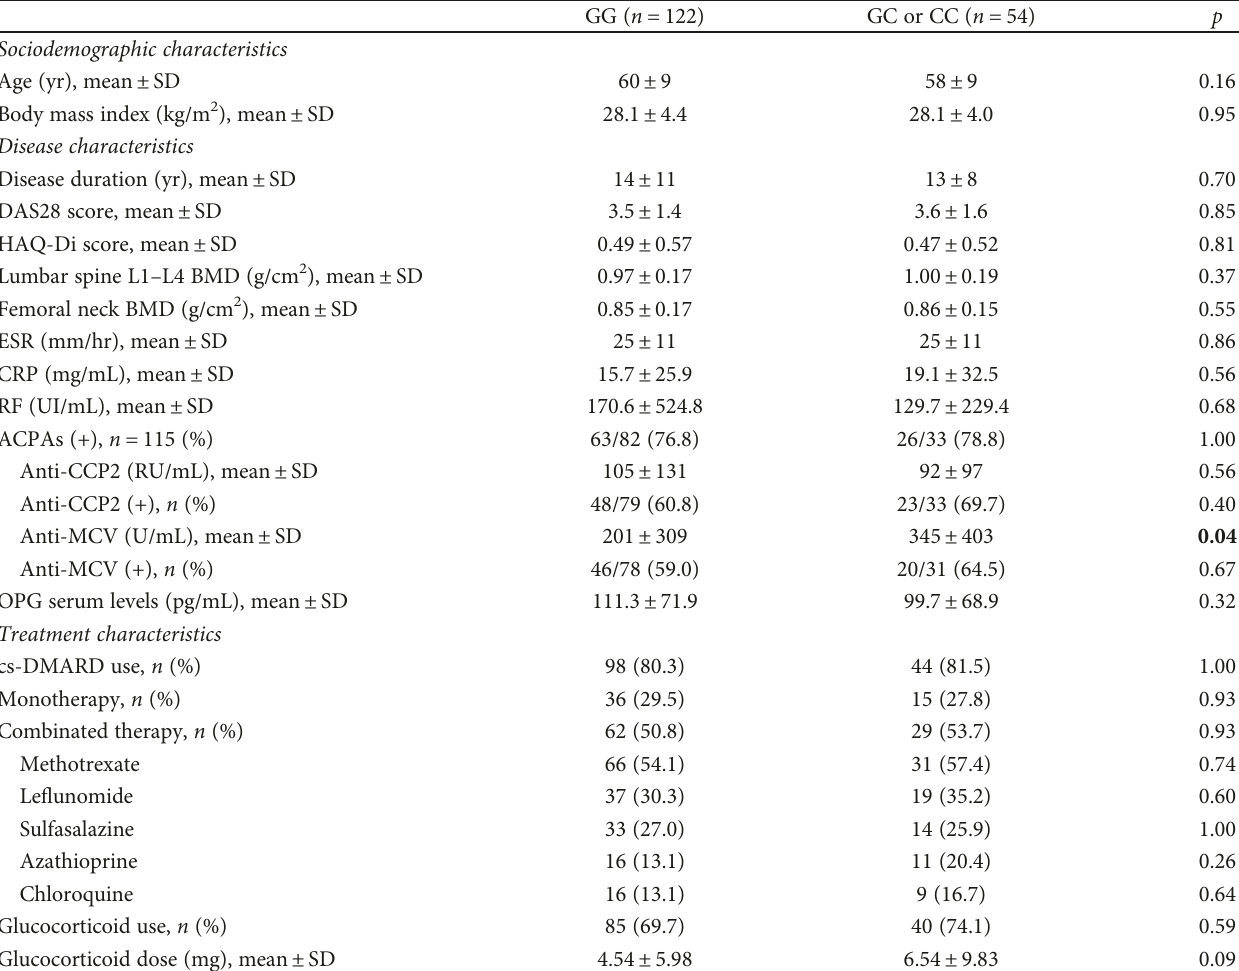
Table 2: Comparison of sociodemographic, clinical, and laboratory characteristics between GG genotype carriers and GC or CC genotype carriers in patients with rheumatoid arthritis